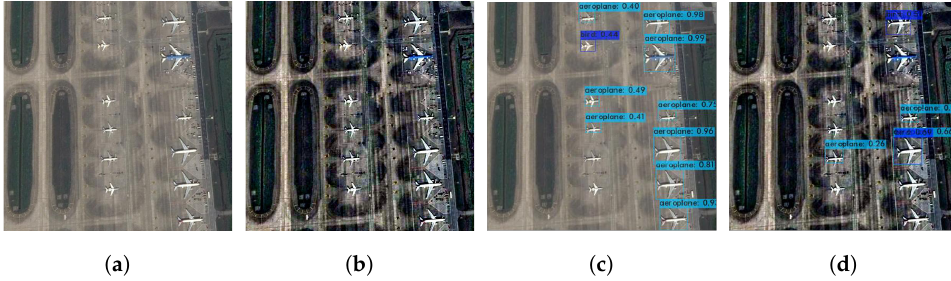
Figure 2. Illustration of the negative effects of image dehazing on an aerial surveillance application when the input image is clean. ( a , b ) A clean image and its corresponding dehazed result. ( c , d ) De- tection results obtained after processing of ( a , b ) by a YOLOv4-based high-level object recognition algorithm. Notes: ( a , c ) were adopted from Figure 1a,d. Cyan labels represent airplanes, and navy-blue labels represent